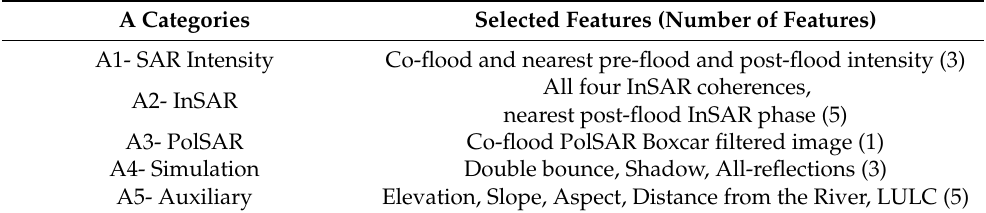
Table 6. Selected features from A Categories.